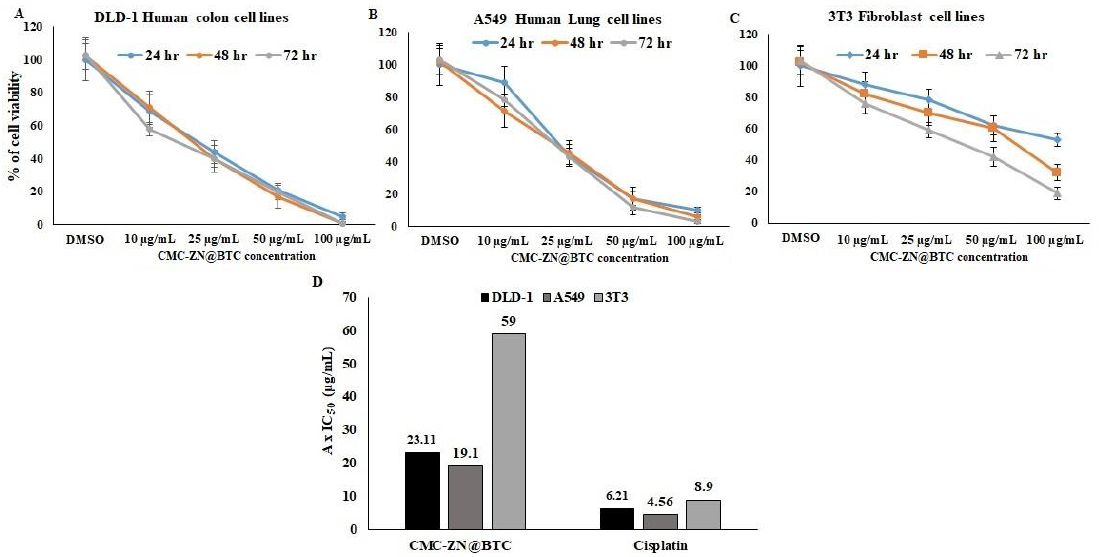
Figure 6. In vitro anticancer activity of CMC/Zn@BTC on ( A ) colon cancer cell lines, ( B ) lungcancer cell lines, ( C ) normal cell lines. ( D ) represents collective graph to compare against